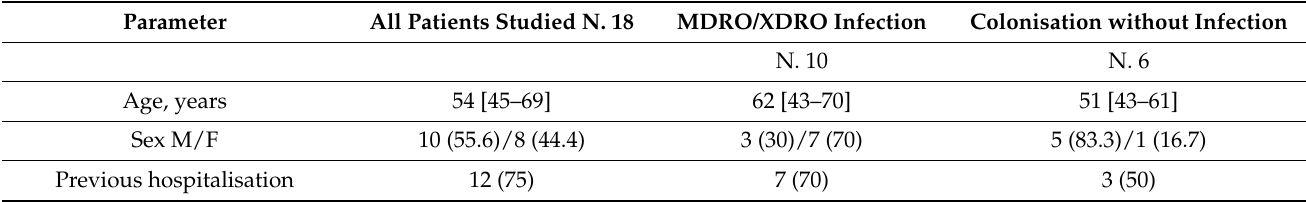
Table 1. Baseline characteristics of patients included in the study. Parameter All Patients Studied N.